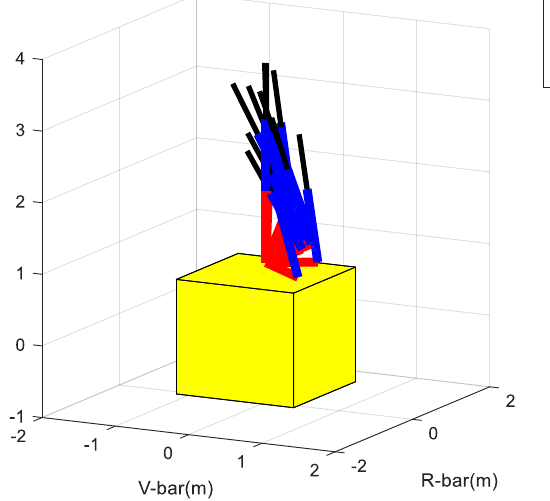
Figure 11. Path planning results.